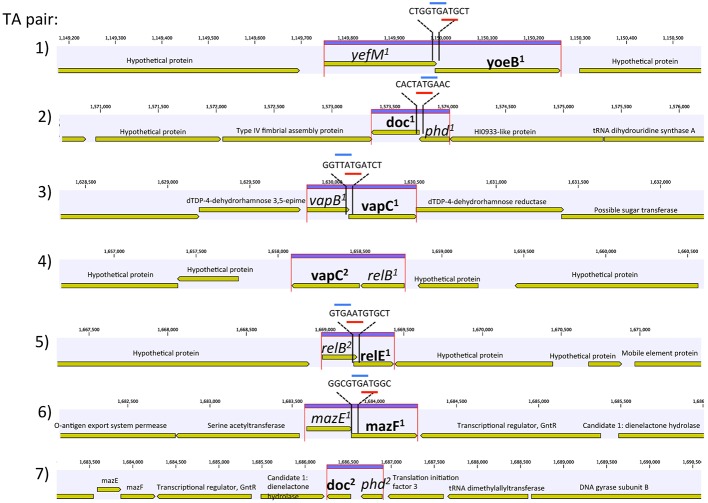
Genetic organization of the seven toxin–antitoxin (TA) systems of Synechococcus CB0101. Schematic representation of the seven TA pairs (highlighted in purple) and associated genes. Gene overlap is depicted by overlay with blue and red representing start and stop codons, respectively. Toxin is represented by bold and antitoxin by italics.